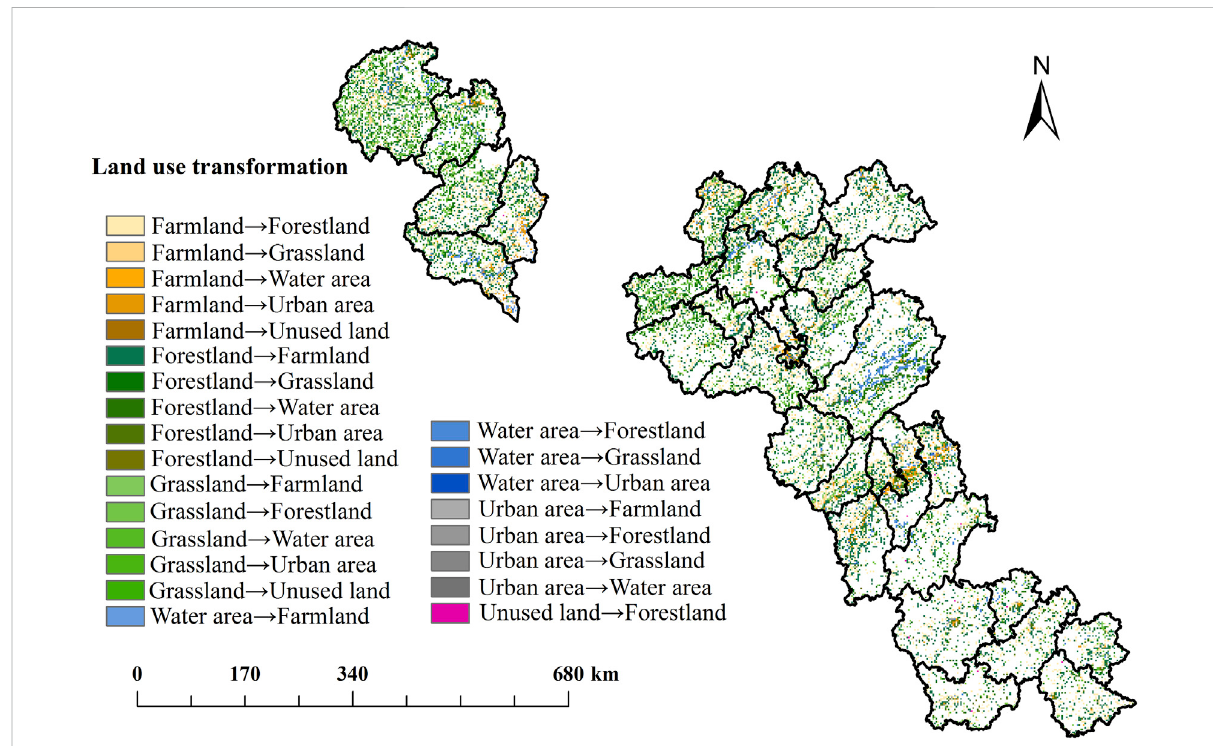
FIGURE 4 Spatial distribution map of land use type transfer in YRDEB from 2000 to 2019. Changes of ESV and sensitivity test.